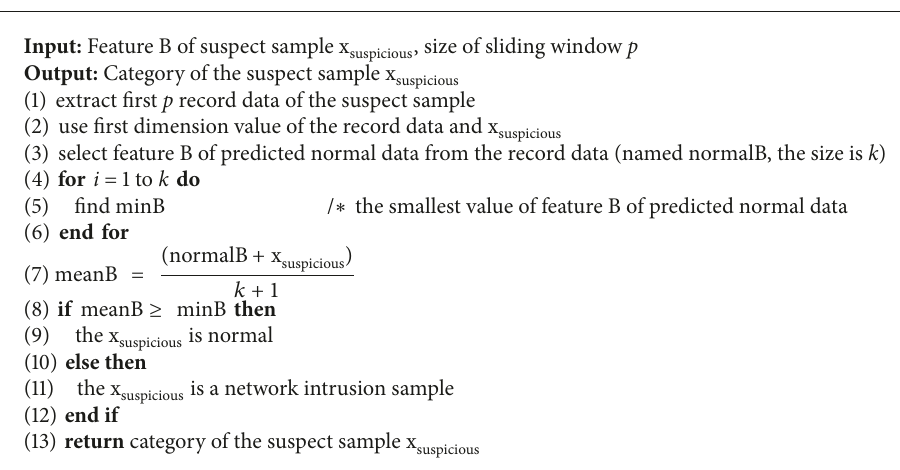
Algorithm 2: Sliding window